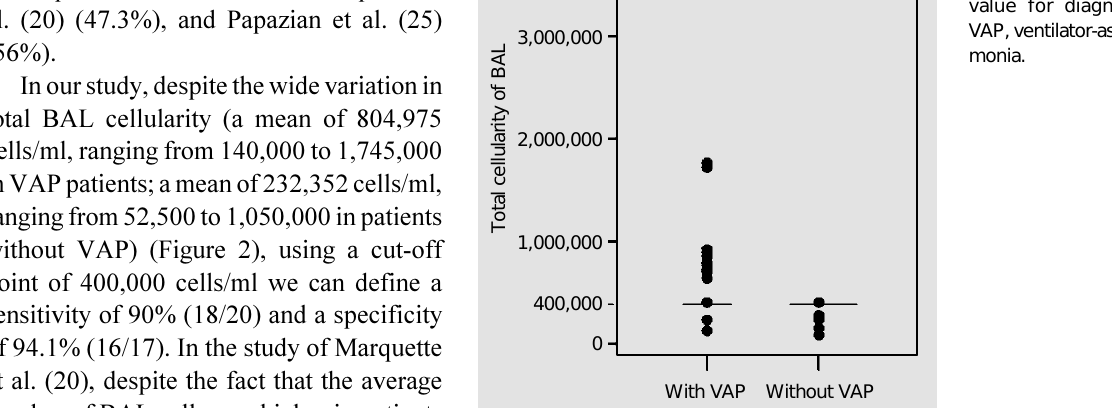
Figure 2. Total number of cells in bronchoalveolar lavage (BAL) from the two groups of patients studied showing the cut-off value for diagnostic validity. VAP, ventilator-associated pneu-